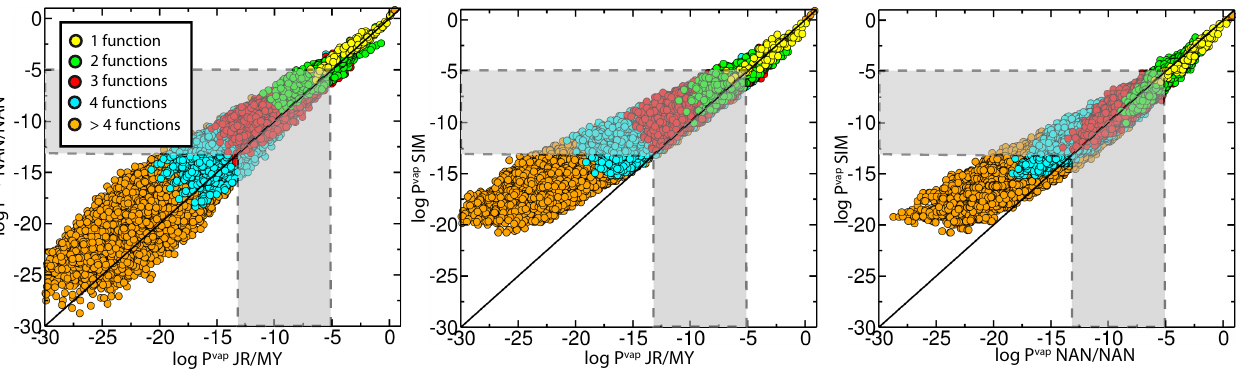
Fig. 4. Scatter plot of P vap estimated by JR/MY, NAN/NAN and SIM for the secondary species generated during α -pinene oxidation. Shaded areas define the semi-volatile domain of particular interest for atmospheric applications (10 − 13 and 10 − 5 atm).